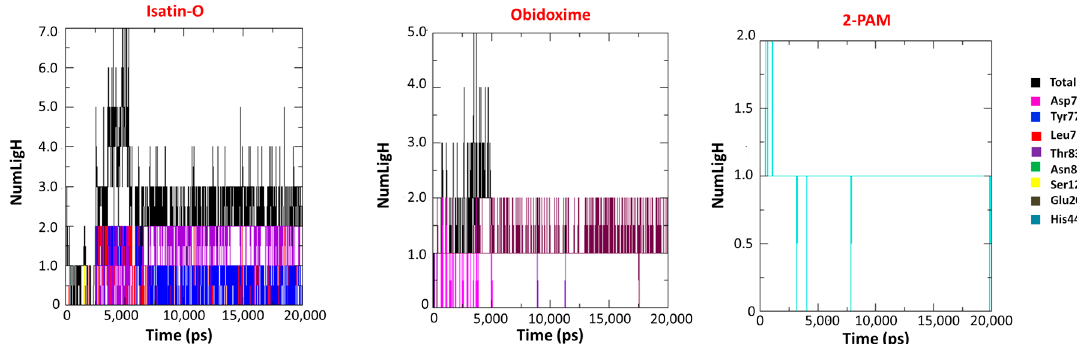
Figure 10. H-bond prevalence for the systems Ee AChE/POX/oximes.